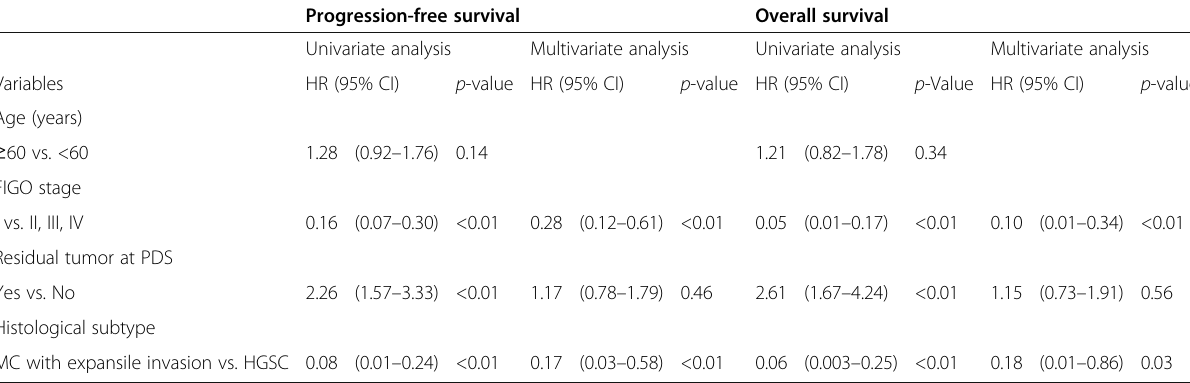
Table 4 Survival analysis for cases of mucinous carcinoma with expansile invasion and high-grade serous